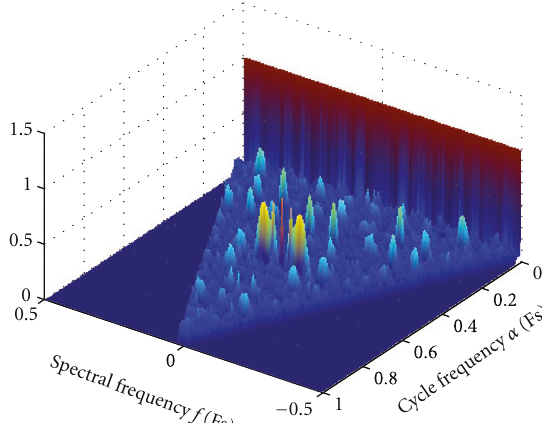
Figure 4: SOF of a BFSK signal in a Multipath Fading Channel at 5dB SNR, with 1/Ts = Fs/10, Fc = 0.25 Fs, no. of samples = 4096.